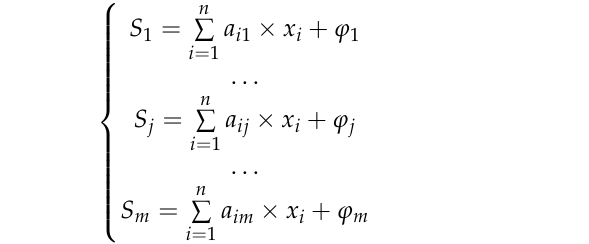
Figure 2. Simplified model of radiation emission from the shelter object.